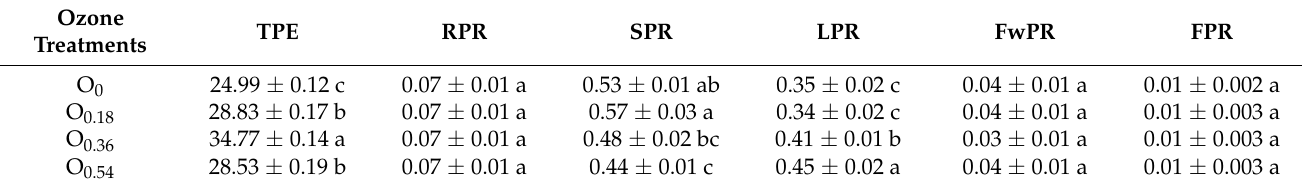
Table 14. Effect of O 3 dosage on total phosphorus extracted by plant (TPE) (mg plant − 1 ) and their distribution in root (RPR), stem (SPR), leaf (LPR), flower (FwPR), and fruit (FPR) (dimensionless). The data recorded are the means ± standard deviation of four samples per treatment at the end of the experimental period. In each column, different letters denote statistically significant changes between treatments (LSD test; p < 0.05).